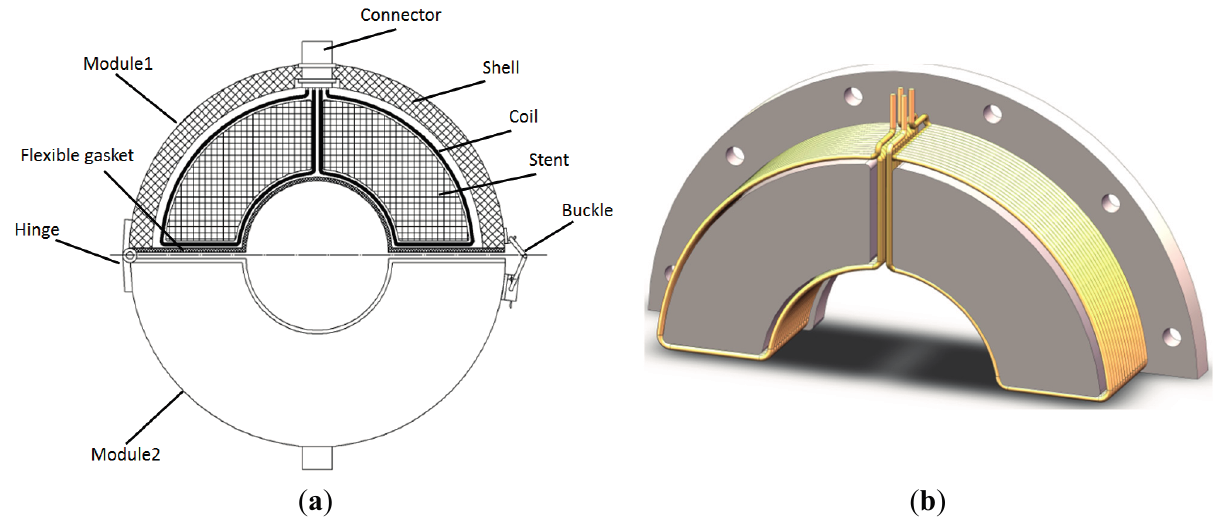
Figure 2. Schematic diagram of the prototype sensor used to obtain the F(1,3) and F(2,3) modes. ( a ) The sensor structure; ( b ) the coil structure in each